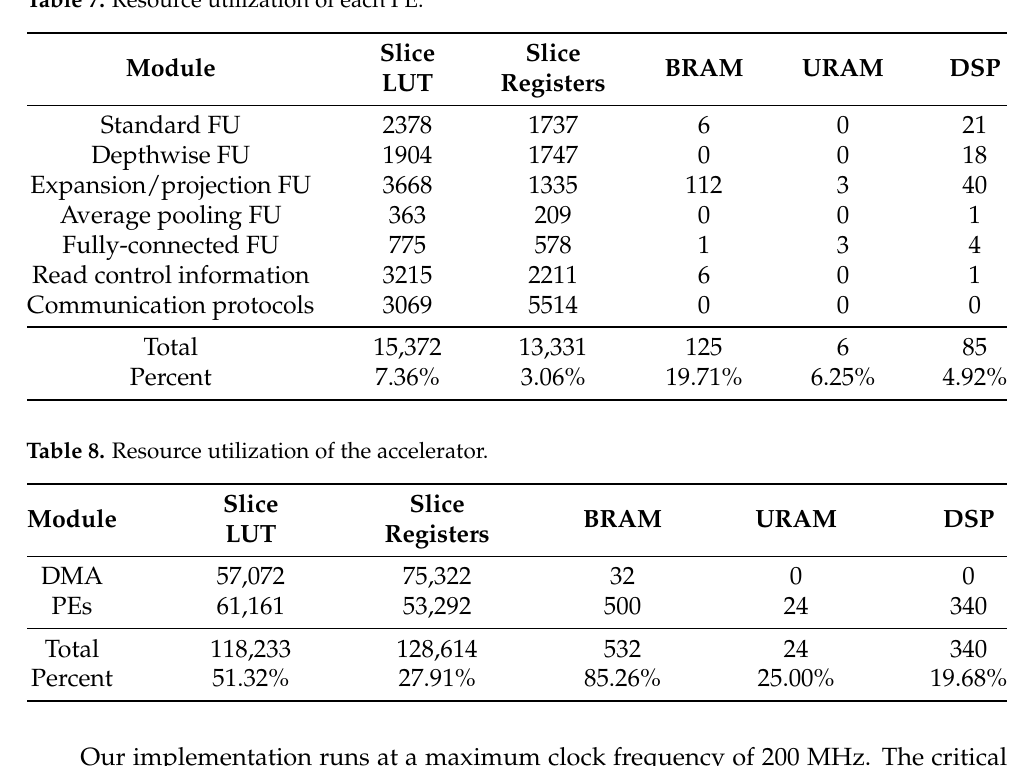
Table 7. Resource utilization of each PE.